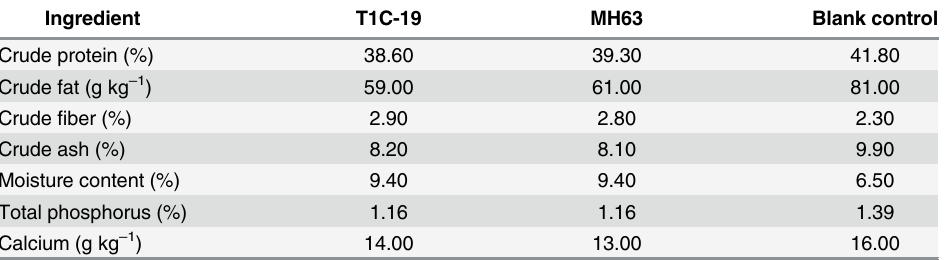
Note: Data in the table are measured